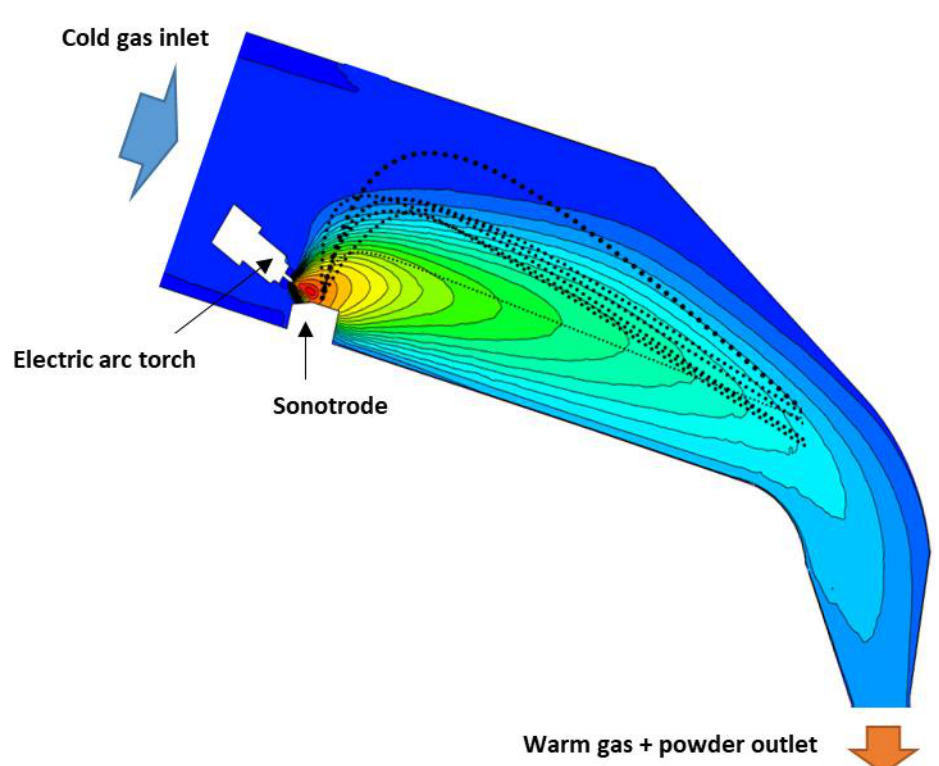
Figure 1. Atomization chamber with the temperature profile of the gas and droplet trajectories during the atomization.